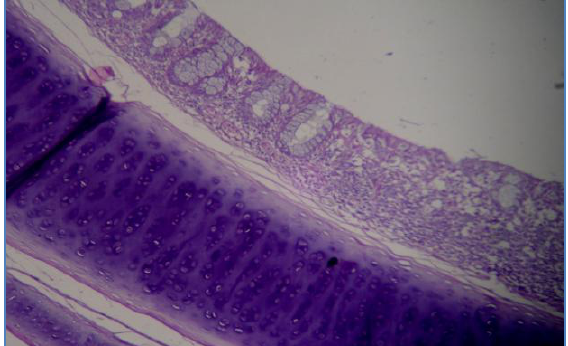
Figure, 3: Contact trachea shows normal tissue, 72 hrs. post infection, (H and E) (100X).